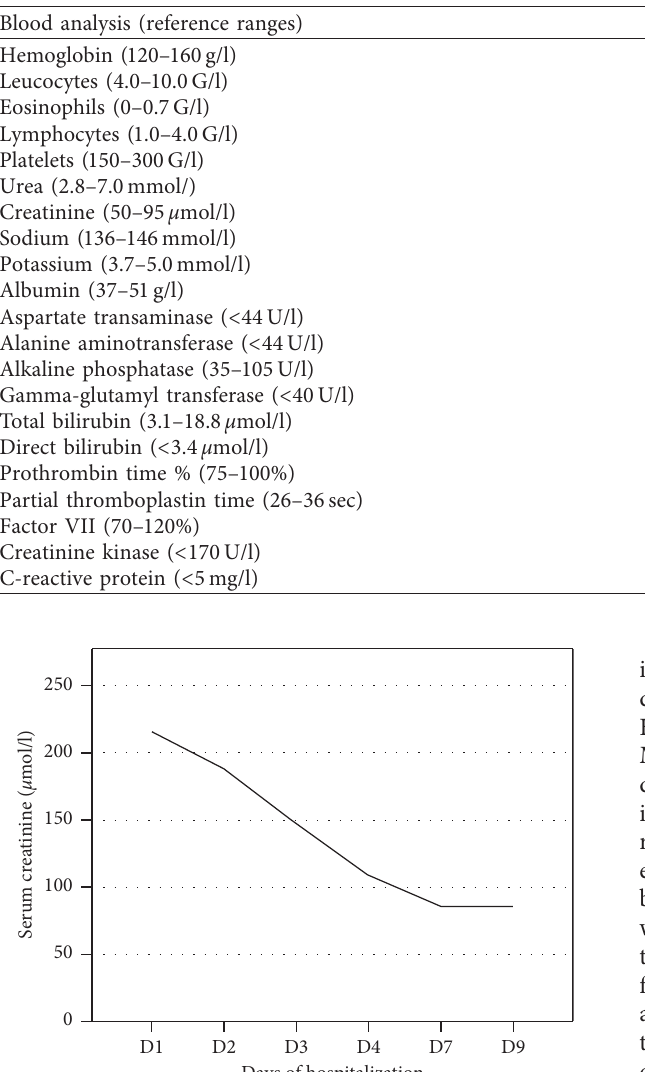
Figure 1: Time course of creatinine after stopping rivaroxaban from admission up to day 9, the day of discharge from our